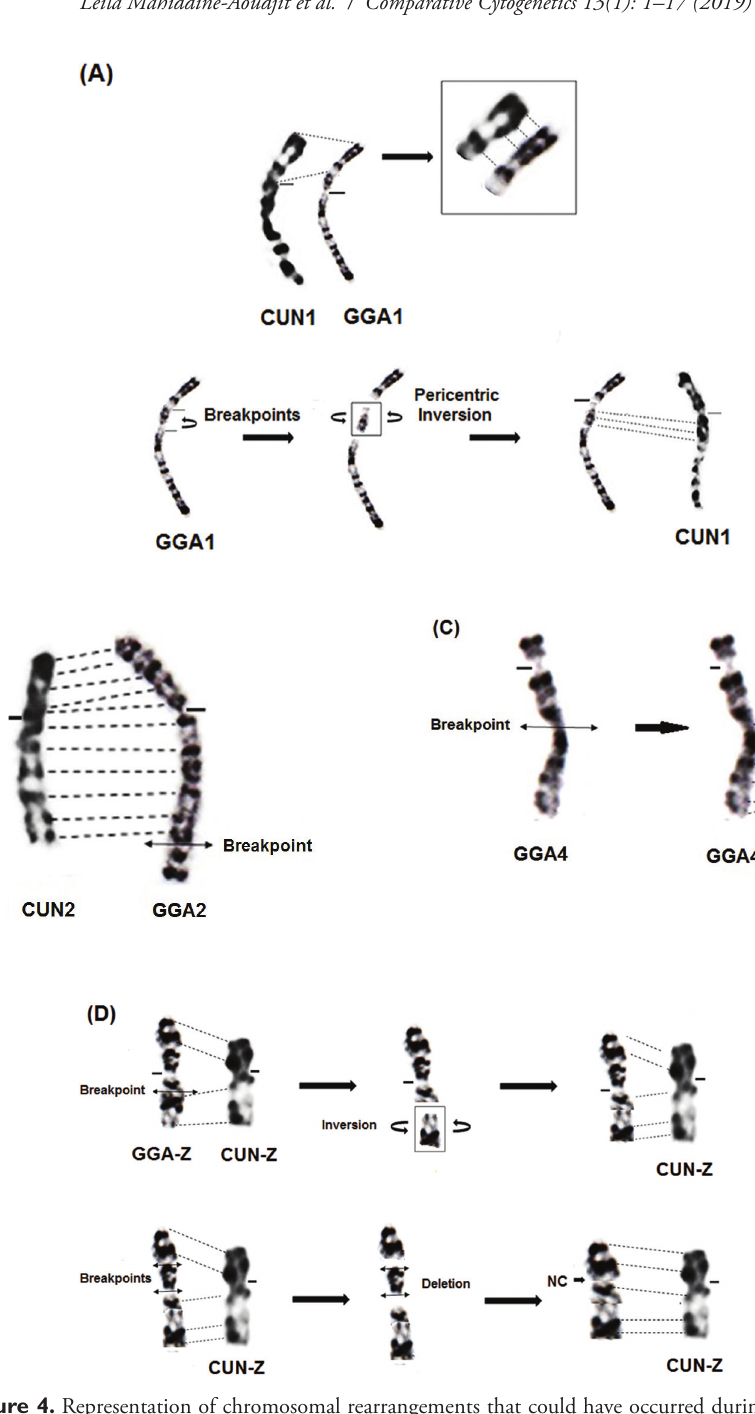
Figure 4. Representation of chromosomal rearrangements that could have occurred during the forma- tion of the chromosome 1 ( A ) , the chromosome 2 ( B ) , the chromosome 4 ( C ) and the chromosome Z ( D ) of the Houbara